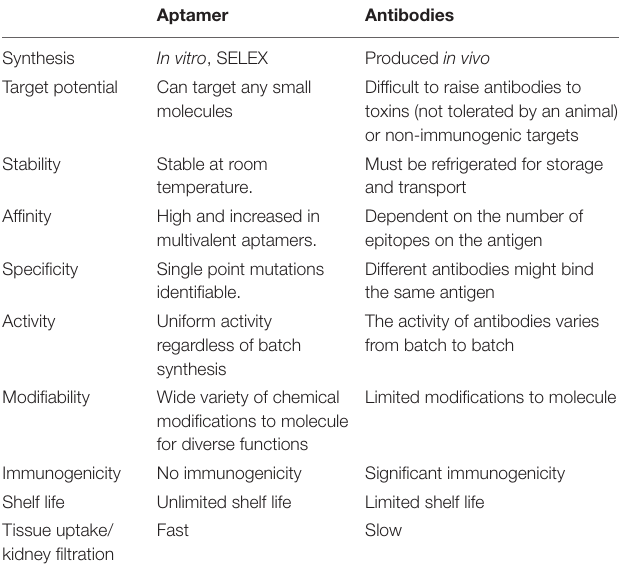
TABLE 1 | Comparison of aptamers and